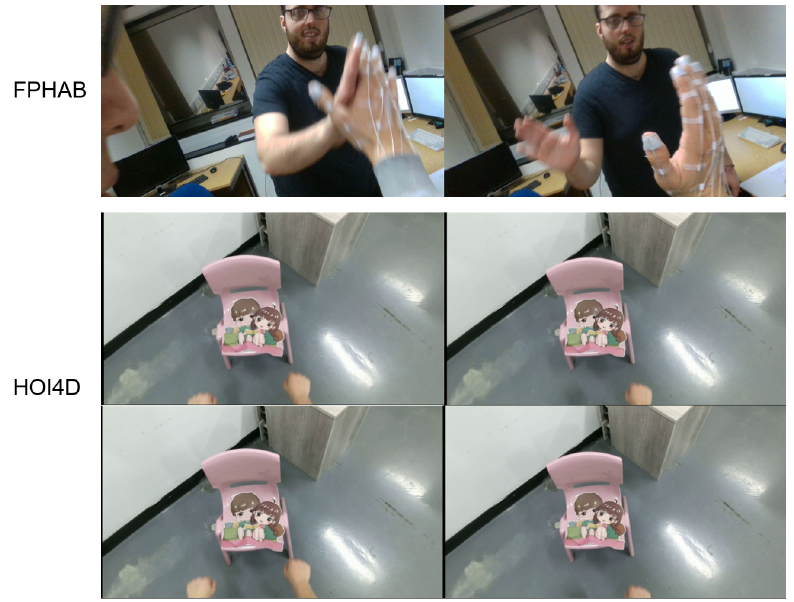
Figure 3. Illustrating some cases where the hand cannot be detected in the image when using the GM on the FPHAB and HOI4D